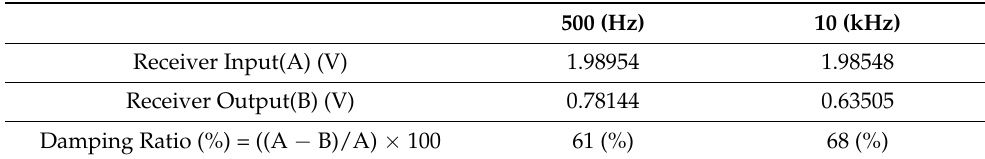
Table 2. Input/output characteristics of the receiver against disturbance.